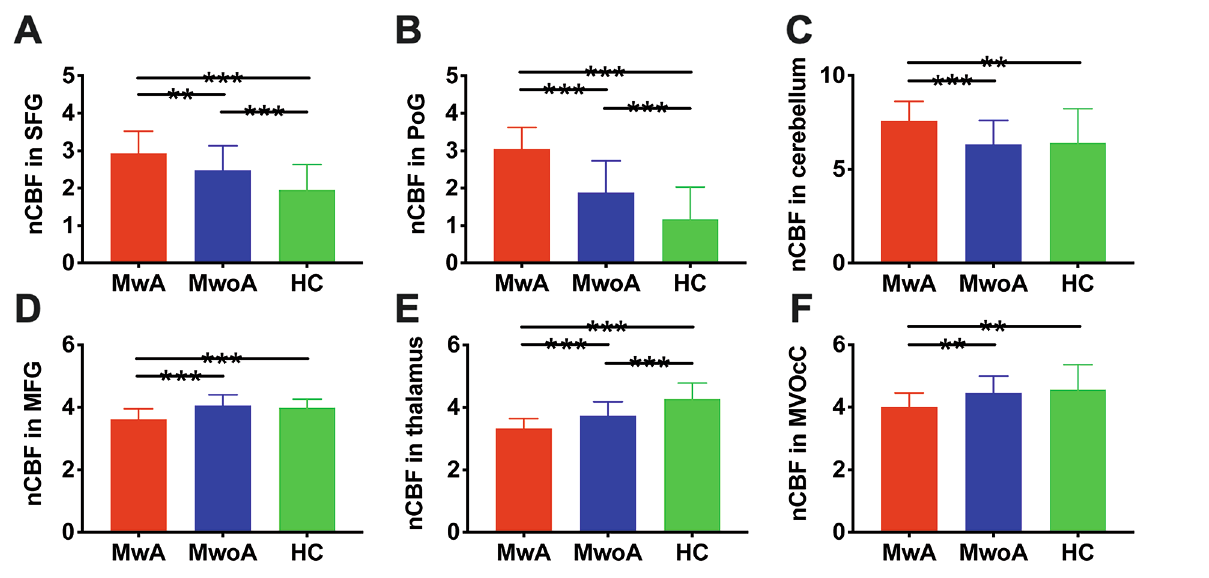
Fig. 2 ROI-based comparison among MwA, MwoA and HC. The normalized CBF in six ROIs including superior frontal gyrus (SFG), postcentral gyrus (PoG), cerebellum, middle frontal gyrus (MFG), thalamus and medioventral occipital cortex (MVOcC) all showed significant differences between MwA and MwoA patients, and also between MwA and HC. Statistical significance is indicated by asterisks (***, p < 0.001; **, p < 0.01). HC: healthy controls, MwA: migraine patients with aura, MwoA: migraine patients without aura, nCBF: normalized cerebral blood